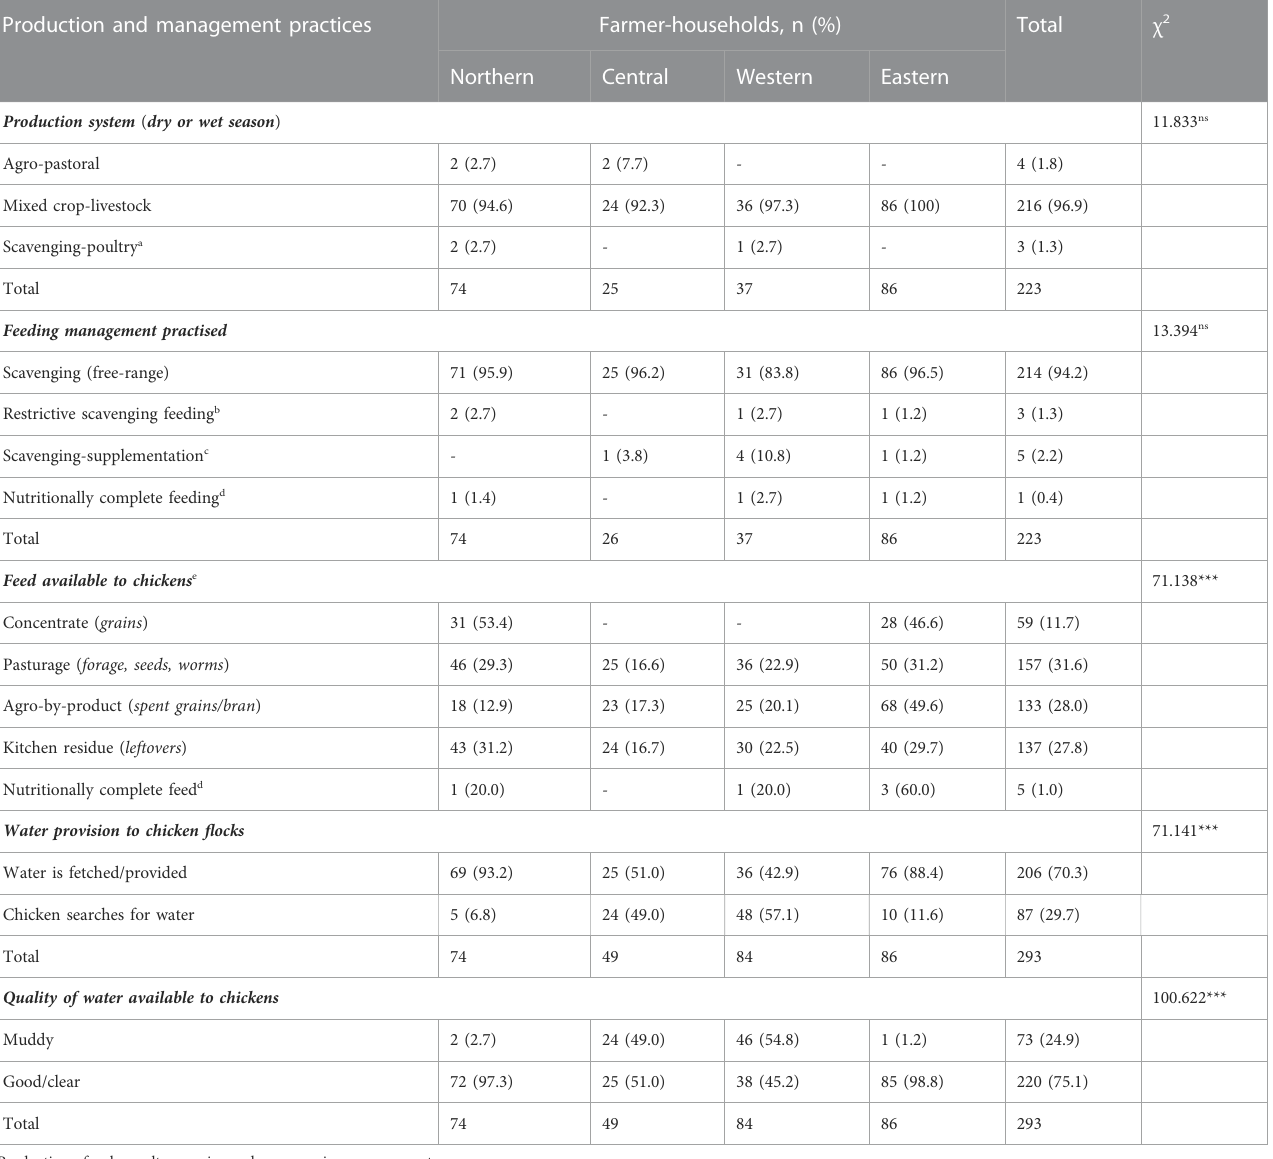
TABLE 4 Indigenous chicken production and management practices in Uganda. Production and management